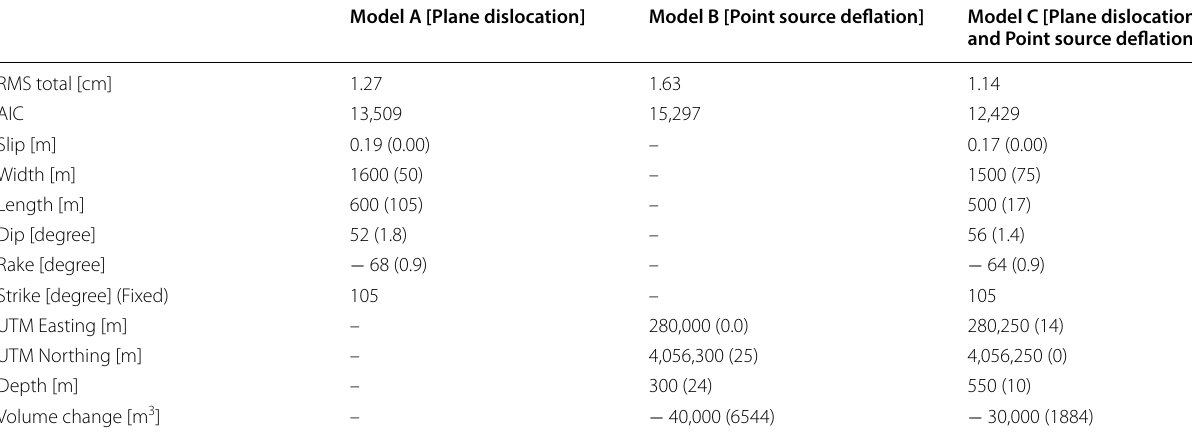
Standard errors are shown in parentheses